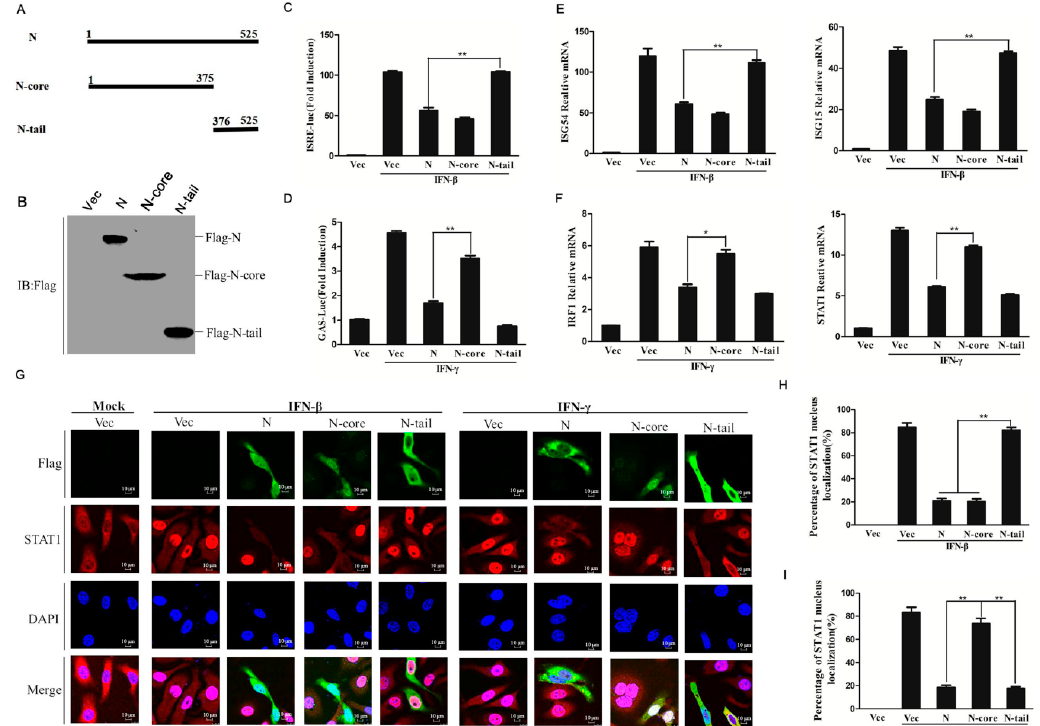
Figure 5. N-core domain and N-tail domain of PPRV N protein show different antagonistic roles